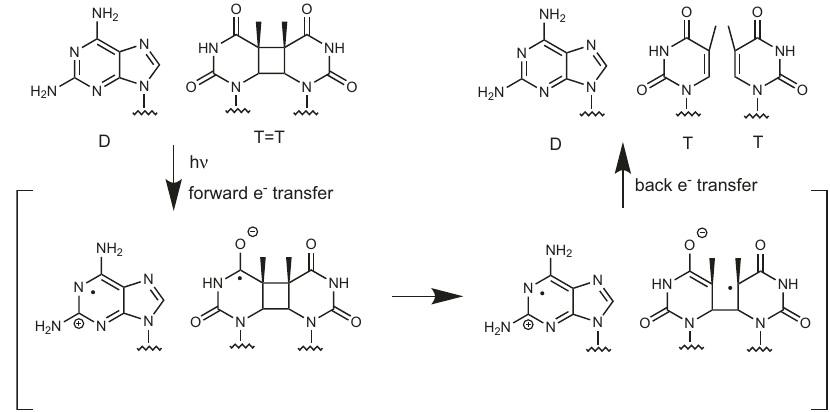
Fig. 1 Schematic representation of the self-repair mechanism of T = T dimers promoted by photoinduced electron transfer from 2,6-diaminopurine (D). This mechanism is analogous to the enzymatic repair induced by the fl avin chromophore acting as the electron donor (Supplementary Fig. 1 in the SI). NATURE COMMUNICATIONS| (2021) 12:3018